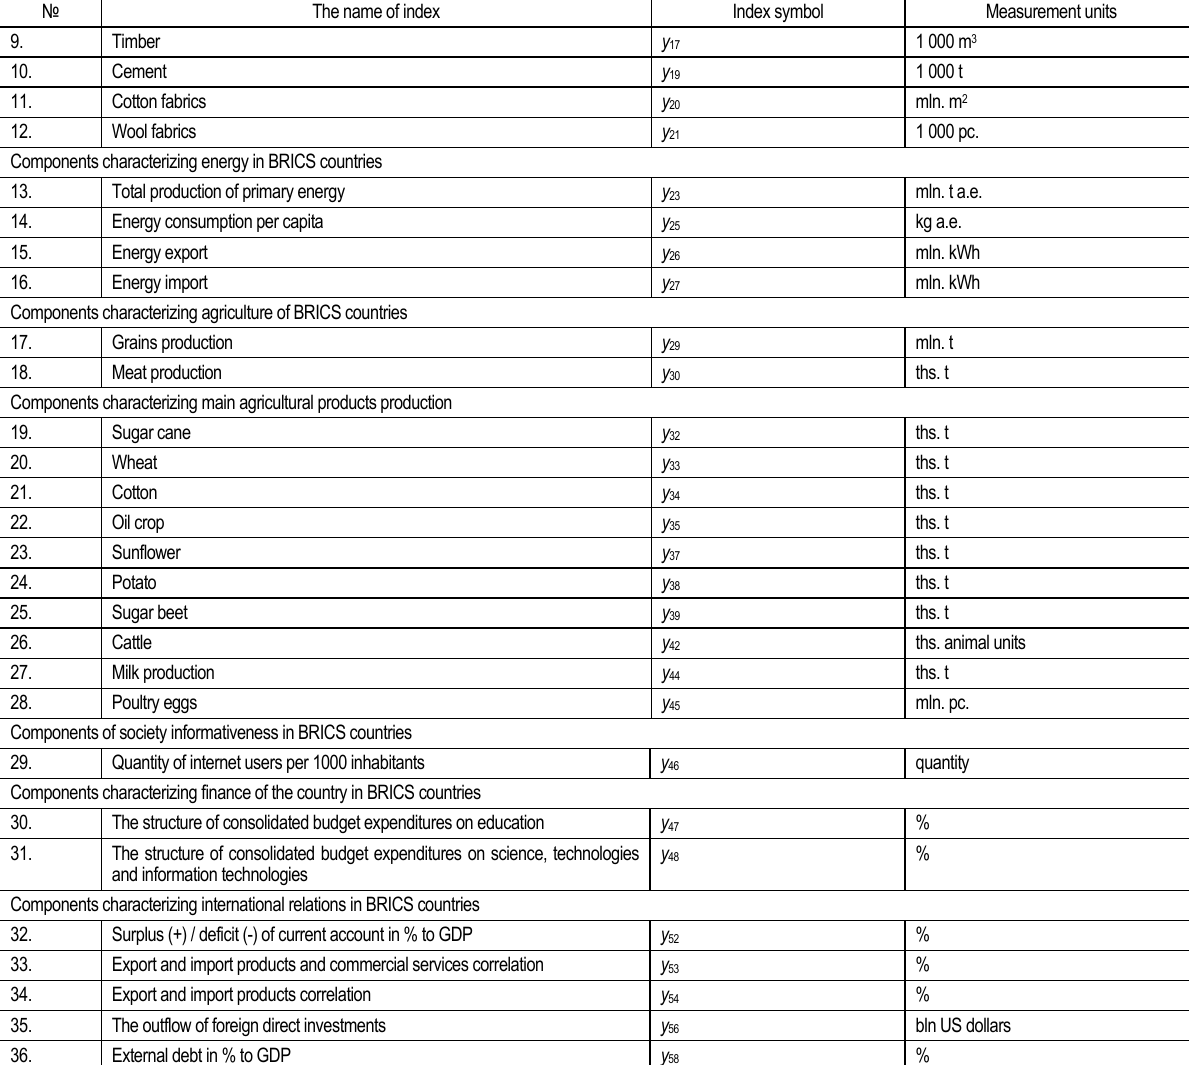
Table 2 (cont.). Integration processes development system, the case of BRICS